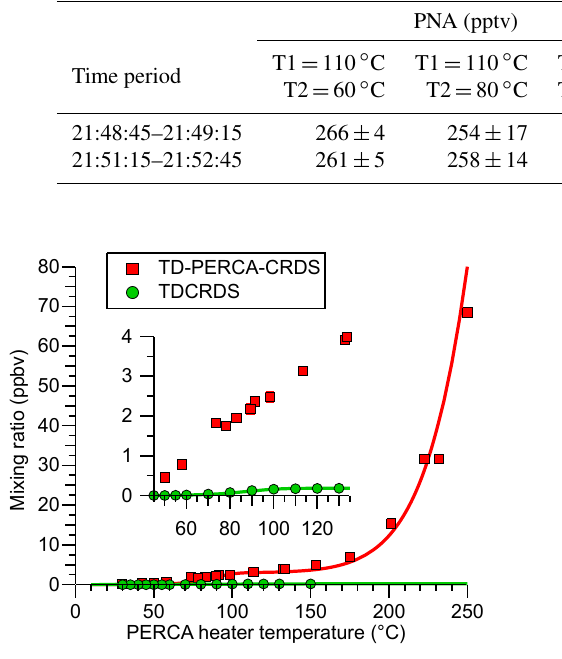
Figure 11. Amplification of photochemically generated PNA (red) as a function of PERCA heater temperature (RH = 24%). Simulta- neous quantification by CIMS and UV absorption showed that the gas stream contained 180 ± 28pptv PNA and 3.5 ± 0.2ppbv O 3 . The non-amplified TD-CRDS signal (from Fig. 4), multiplied by 0.18, is shown in green for comparison.